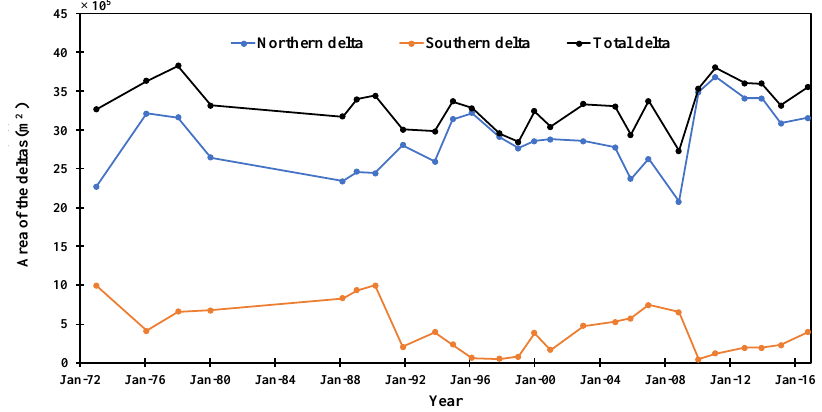
Figure 10. Variation in delta area (northern, southern, and total) from 1972–2016.